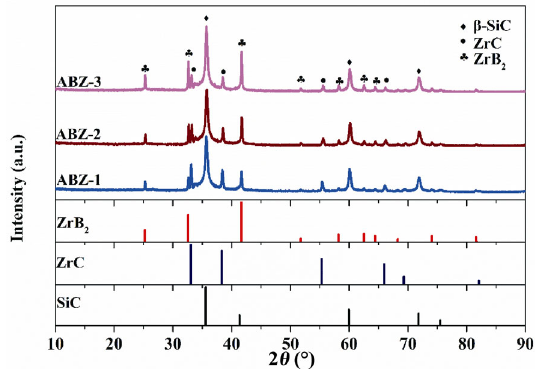
Fig. 6 XRD patterns of single-source-precursor-derived ceramics annealed at 1600 ℃